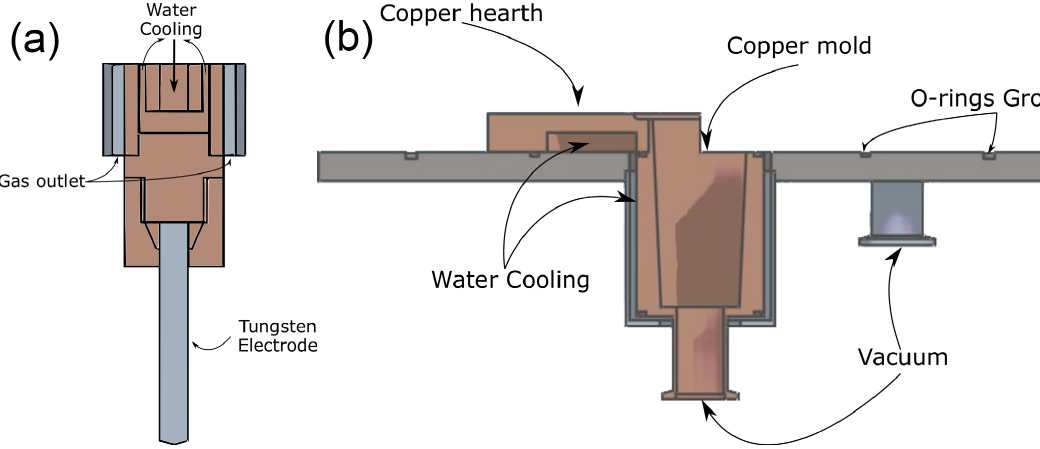
Figure 2: Detailed drawing of (a) arc-melting electrode and (b) furnace base, copper base and conical assembly for the